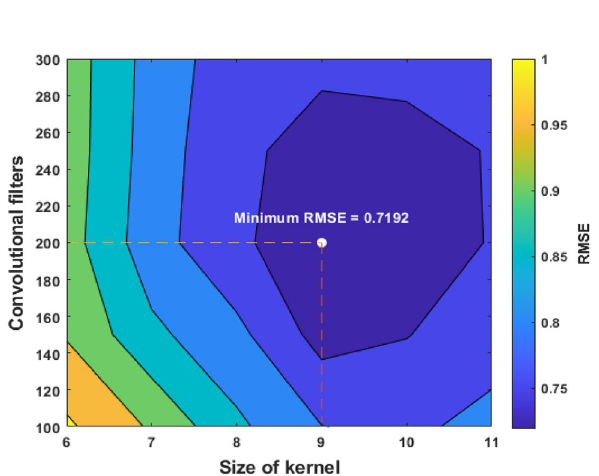
Fig. 17 RMSE variations with respect to the kernel size and the count of convolutional filters in the CNN model